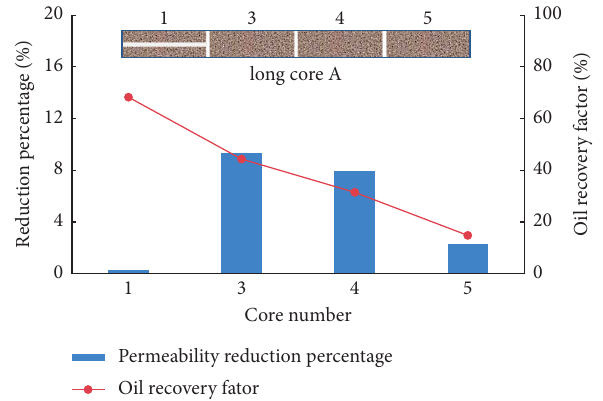
Figure 19: Permeability reduction percentage and oil recovery factor of different cores in long core